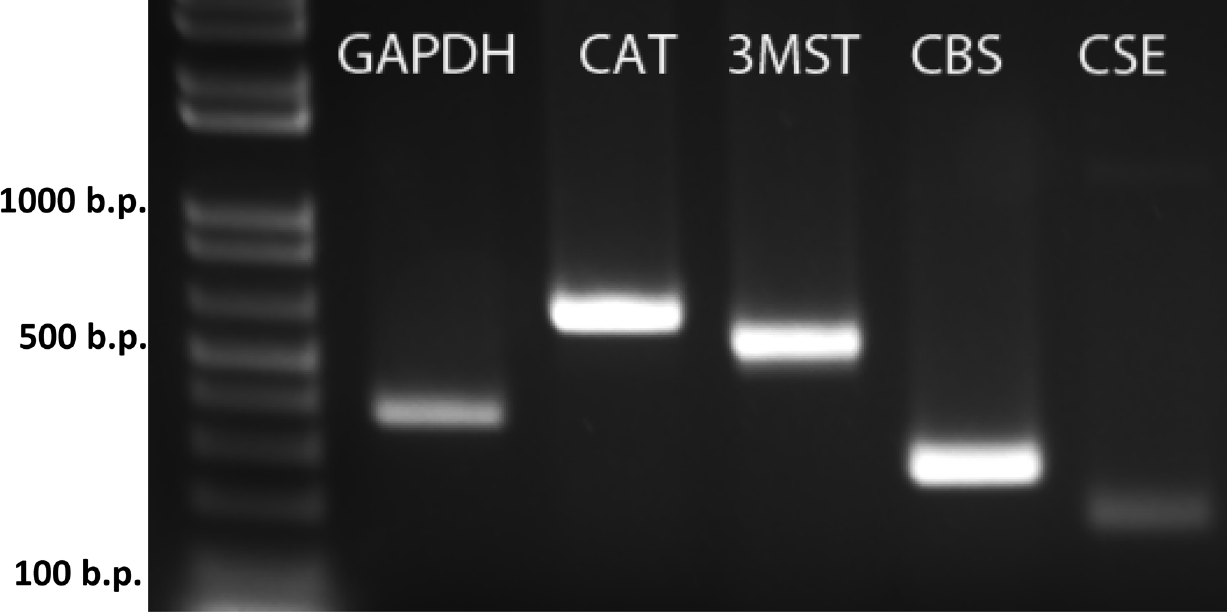
Figure 1. Expression of CAT, 3-MST, CBS, and CSE mRNA in SFO. RT-PCR analysis of SFO shown on an agarose gel with positive bands for the CAT, 3-MST, CBS, and CSE enzymes, as well as a positive control for the housekeeping gene